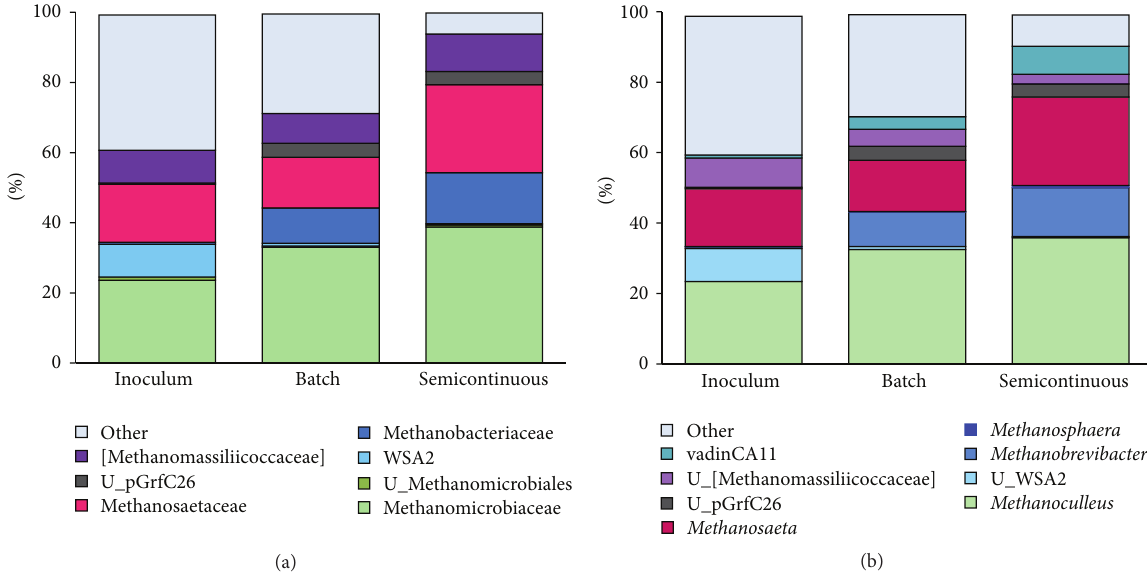
Figure 3: Archaeal distributions. (a) Phylotypes at the family level. (b) Phylotypes at the genera level. Shades of green are for Metha- nomicrobiales (hydrogenotrophic methanogens), blue for Methanobacteriales (hydrogenotrophic methanogens), red for Methanosarcinales (acetoclastic methanogens), and black for pGrfC26. The total NH 3 -N concentration at the time of the batch sampling was 1140mg/L. Semicontinuous operation is an average of two samples at ∼ 2000 mgNH 3 -N/L. “U ” stands for unidentified microorganism within the taxonomic